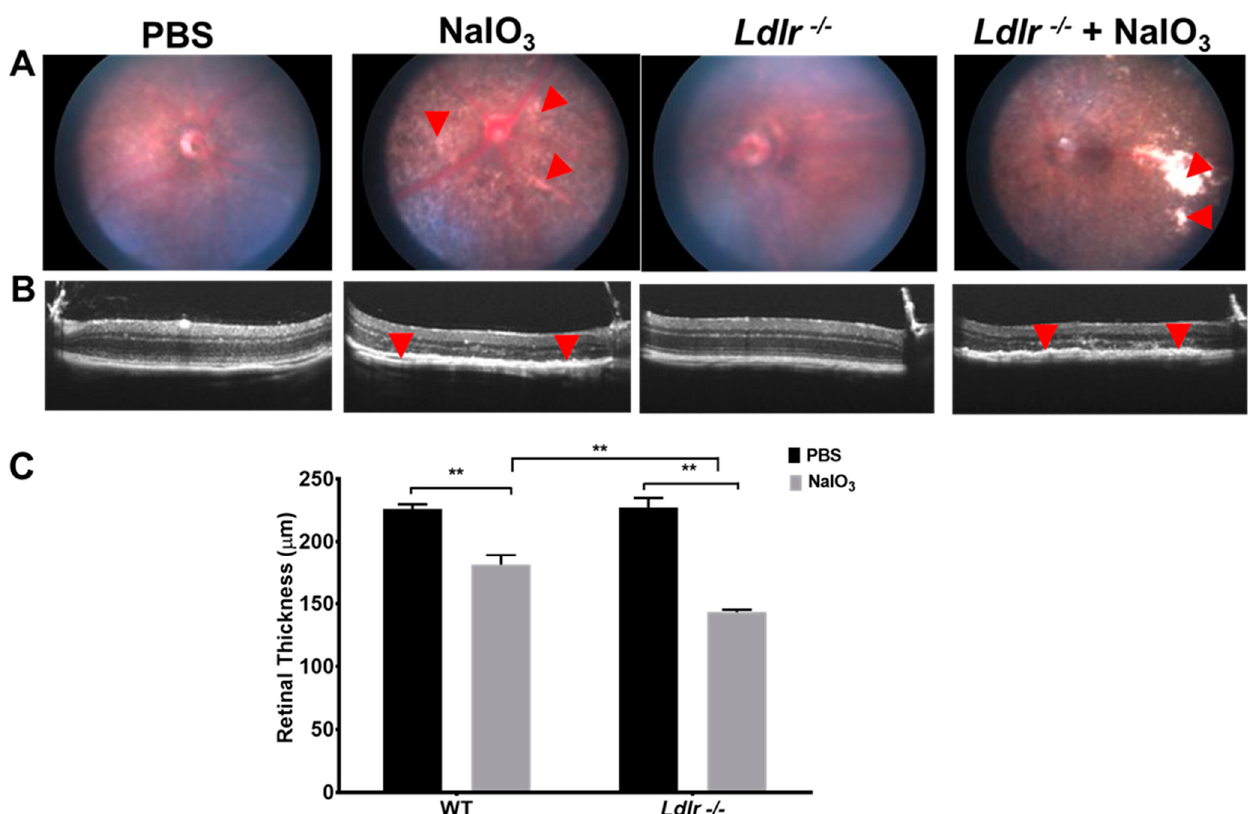
Figure 3. Effect of NaIO 3 treatment on fundus and OCT in 8 wk old WT and Ldlr − / − mice. Mice were administered NaIO 3 (20 mg/kg BW) and fundus ( A ), OCT ( B , C ) were performed on Day 7. In Ldlr -/- mice, retinal degeneration was more severe as evidenced by larger white patches ( A ). NaIO 3 treatment caused significant thinning of the outer layers (red arrow heads) in WT mice which was further significantly decreased in Ldlr − / − mice (red arrow heads) ( B , C ). (mean ± SEM, n =5-6; ** p < 0.01, *** p < 0.001).